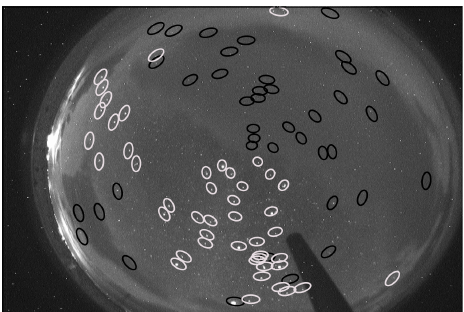
Figure 7: Result of the catalog star and CCD star match- ing. Gray solid circles are matched catalog stars. Black solid circles have no corresponding stars in the CCD pic- ture due to cloud cover.